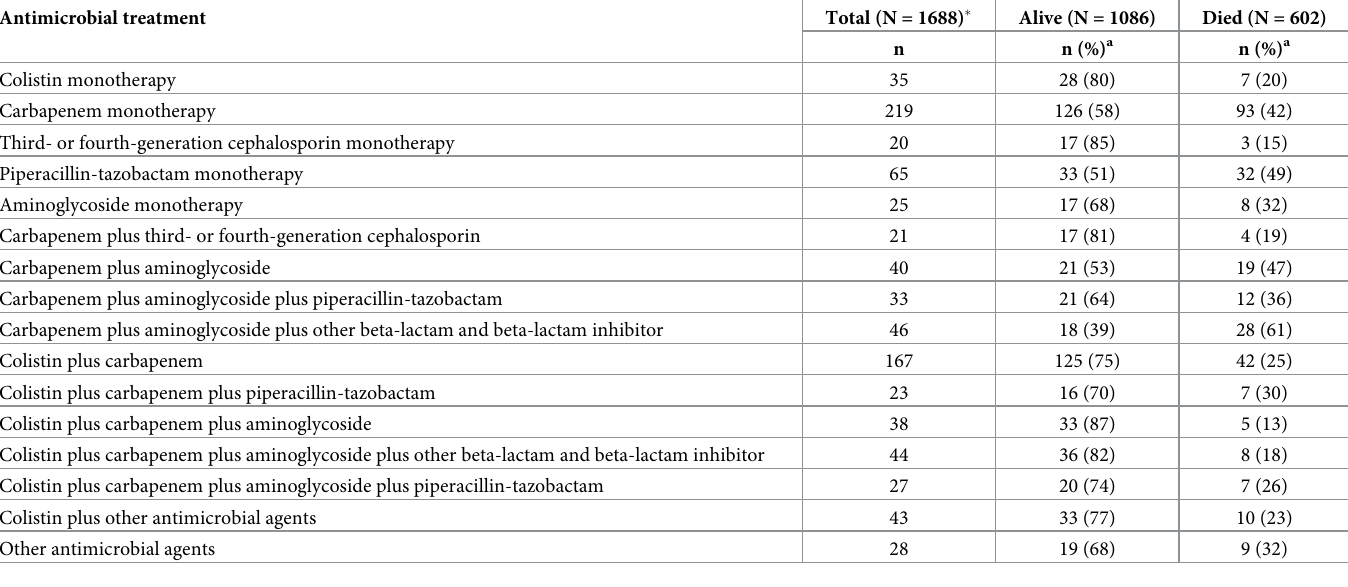
Table 3. Antimicrobial treatment of Acinetobacter baumannii complex (ABC) cases with known patient outcomes in South Africa, 1 August 2018 to 30 September 2019. Antimicrobial treatment